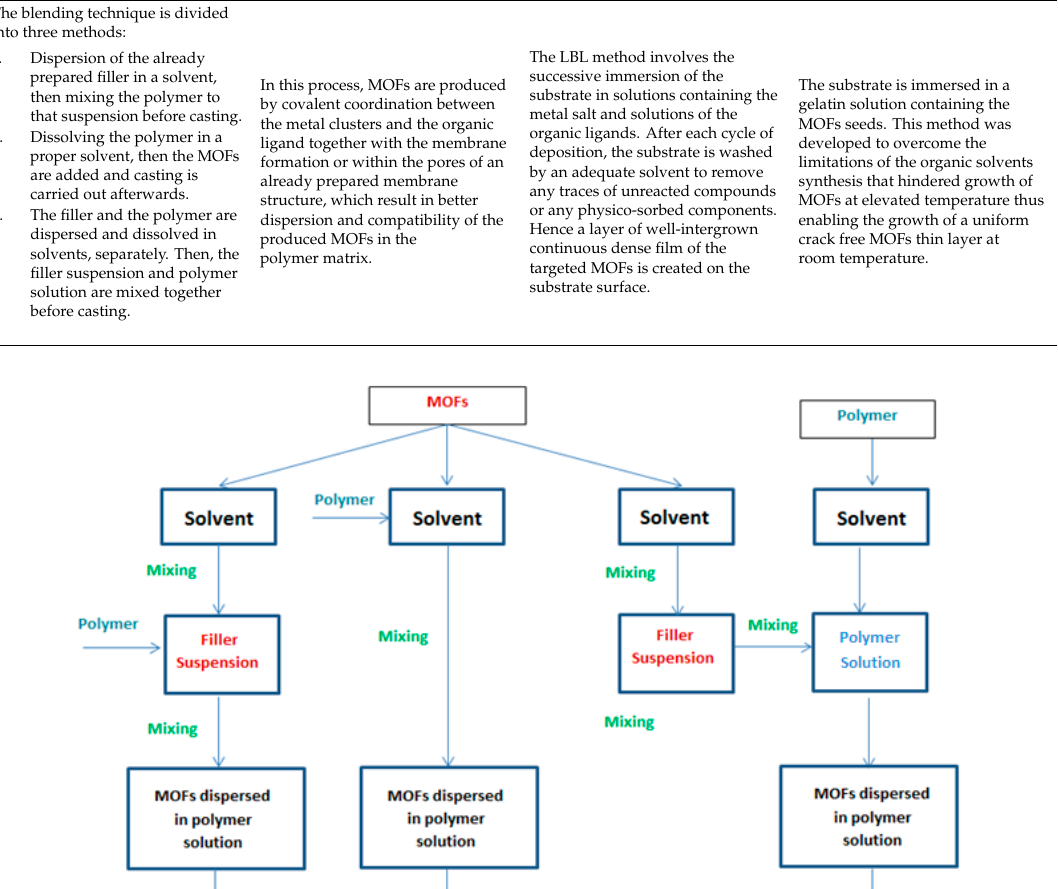
Table 1. Di ff erent synthesis techniques of metal–organic frameworks-mixed metal membranes (MOFs-MMMs).